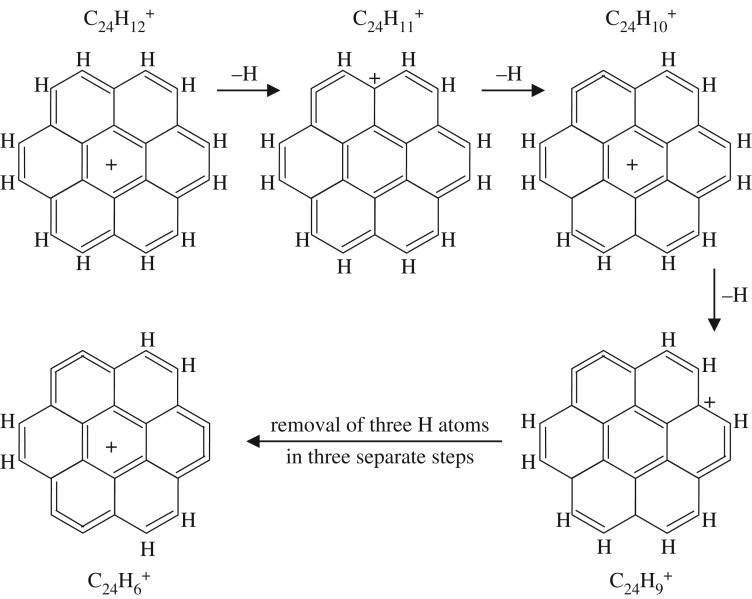
A second possible pathway for the dehydrogenation of the C24H 12+ (S7) coronene cation leading to C24H 6+ structure with a different but equally symmetric structure.